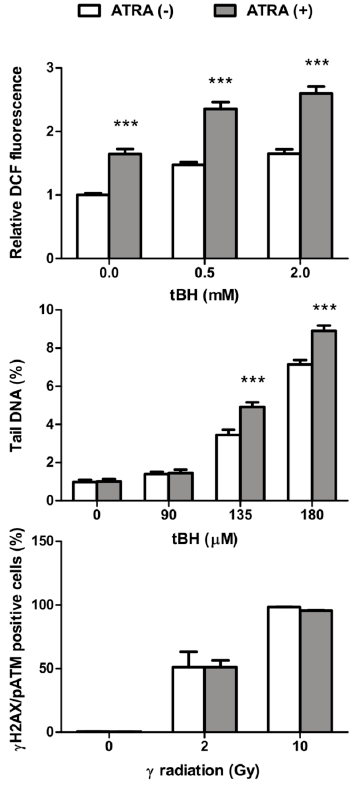
Figure 1. Mean intracellular reactive oxygen species (ROS) levels and DNA damage in all- trans retinoic acid (ATRA)-treated and control ARPE-19 cells exposed to tert -butyl hydroperoxide (tBH). Reactive oxygen species (ROS) are expressed as the relative fluorescence of 2’,7’-dichlorofluorescein (DCF) normalized to controls after 30 min incubation with tBH at 37 °C. DNA damage was measured as a percentage of tail DNA in the comets in alkaline versions of the comet assay following exposure to tBH for 15 min at 37 °C. The induction of DNA double strand breaks was assessed by the extent of phosphorylation of H2AX and ATM (ataxia teleangiectasia mutated) ( γ H2AX and pATM) after γ -ray irradiation (2 Gy/min) of cells. Results are presented as mean ± SEM, n = 12 for ROS level, n = 100 for comet assay, n = 8 for H2AX/ATM phosphorylation, *** p < 0.001.